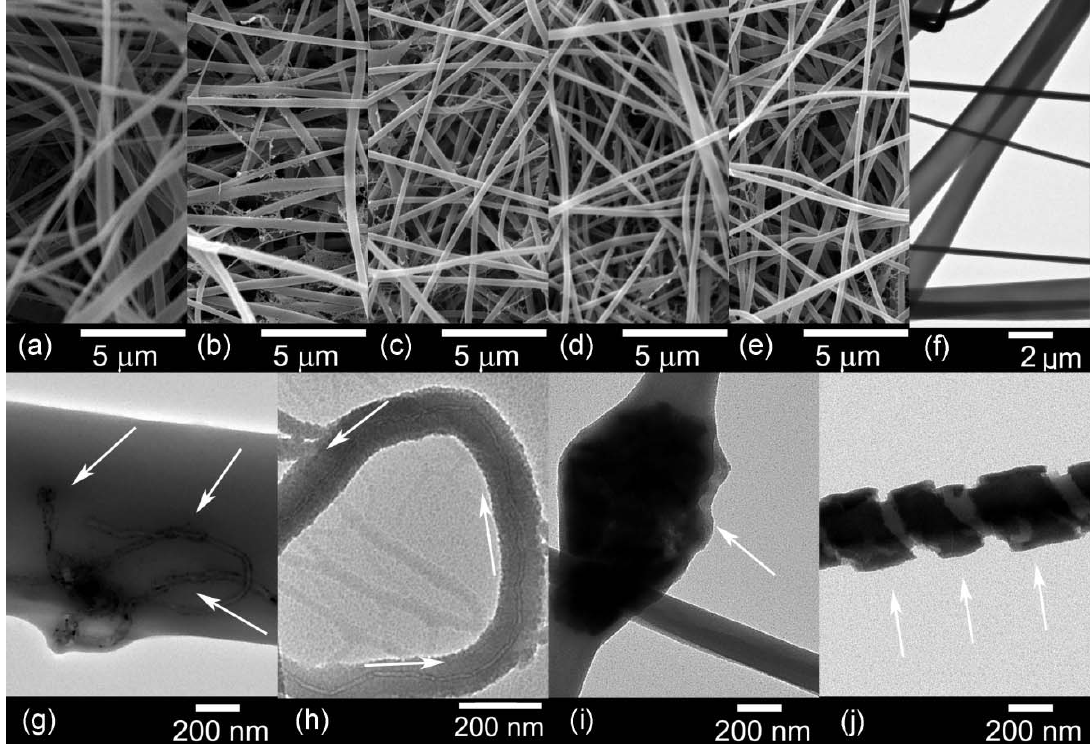
Figure 9. Scanning electron microscopy (SEM) and TEM images of: ( a , f ) pure PA66; ( b , g ) PA66/10CNTs; ( c , h ) PA66/10OCNTs; ( d , i ) PA66/10RGO and ( e , j )